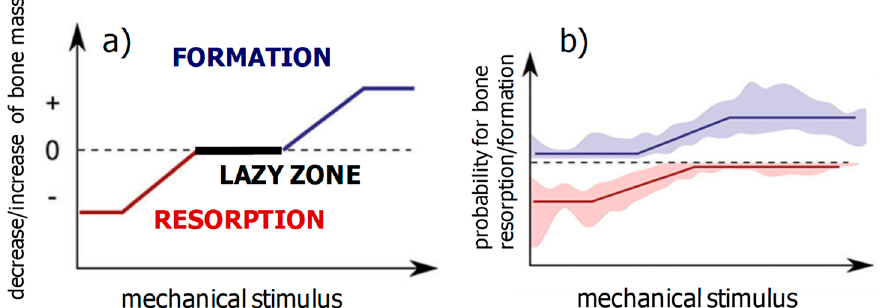
Figure 2. Comparison between a control function, which has been suggested for the mechanoregulation of total bone mass by Harold Frost in his mechanostat theory ( a ), and a control function obtained in experiments on adult mice using a combination of in vivo microcomputed tomography, in vivo loading and Finite Element modeling ( b ) (from [36]).